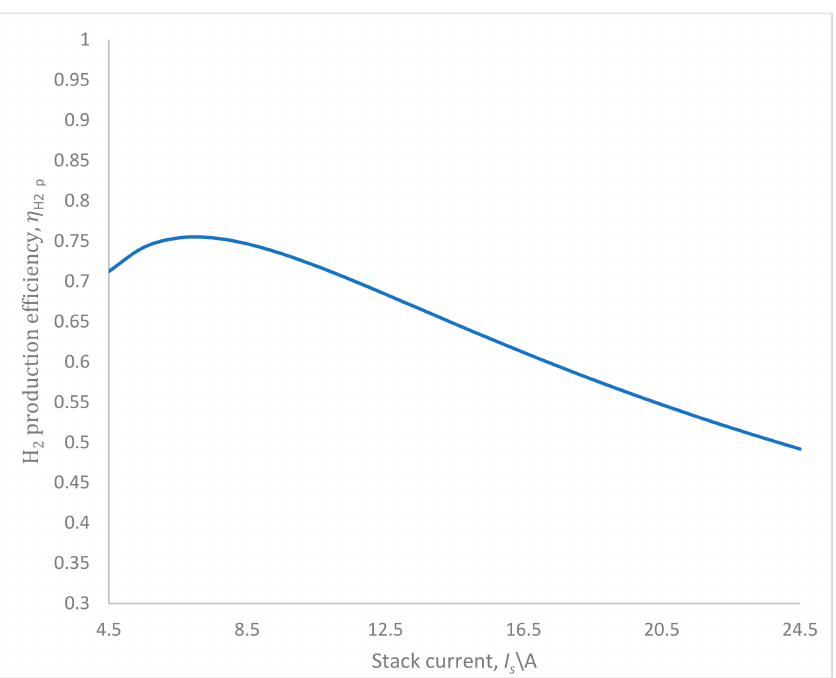
Figure 8. Trend of the hydrogen production efficiency for the PEM electrolyzer system at variable stack operating